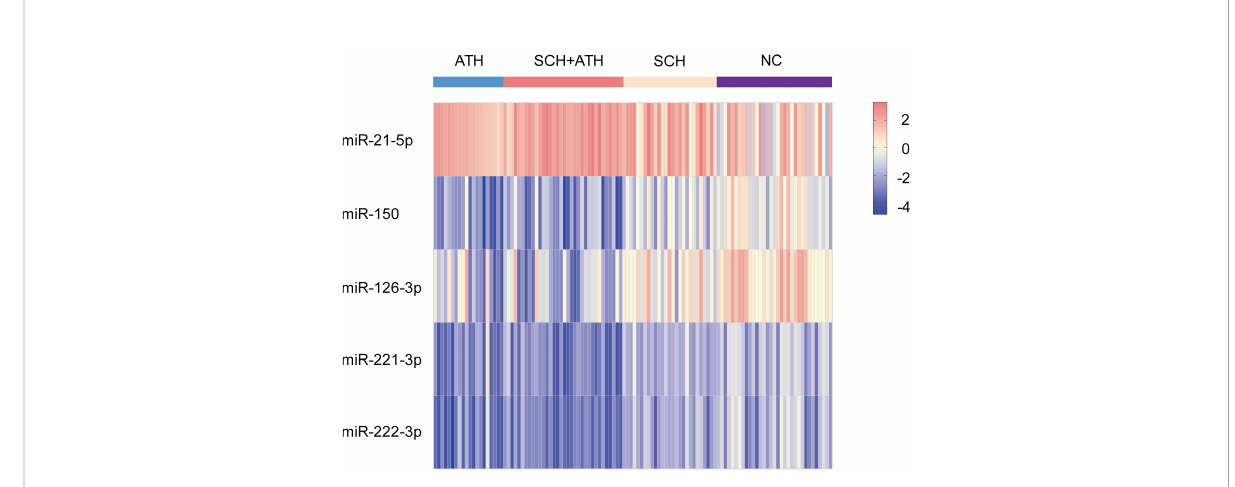
FIGURE 5 The different expression of fi ve miRNAs could be agglomerated in hierarchical agglomerative clustering